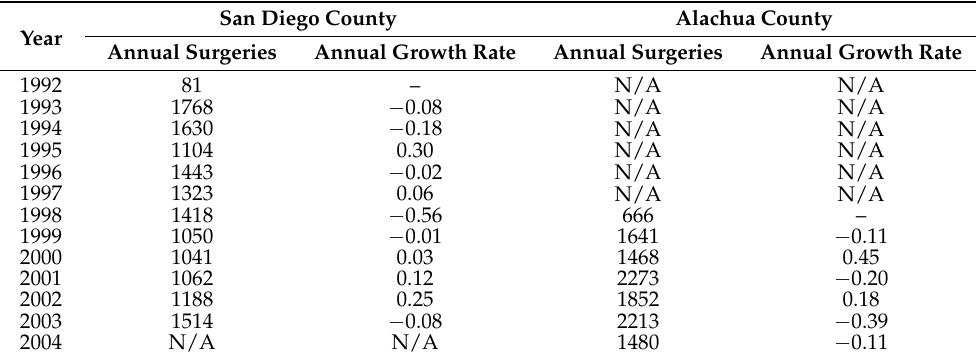
Table 1. Estimated annual surgeries and corresponding annual growth rates adapted from Figure 1 of Foley et al. [22]. As per the original analysis, annual growth rates were not calculated for the first year of each